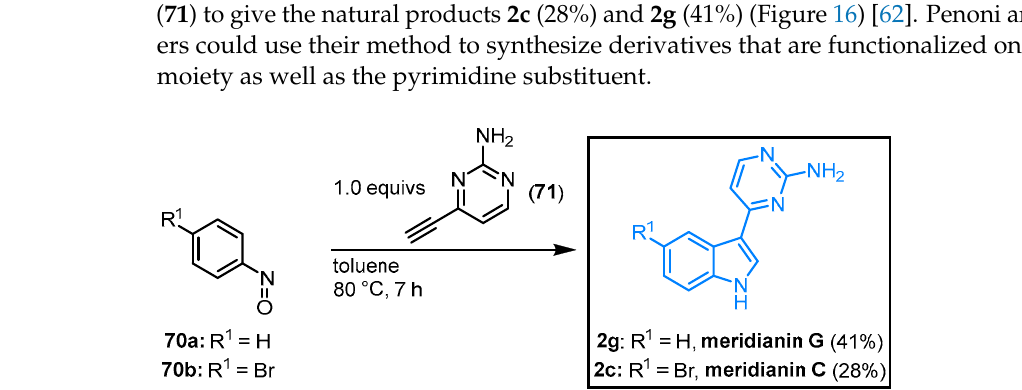
Figure 16. Indolization of nitrosoarenes for the synthesis of meridianins C and G by Penoni [62].